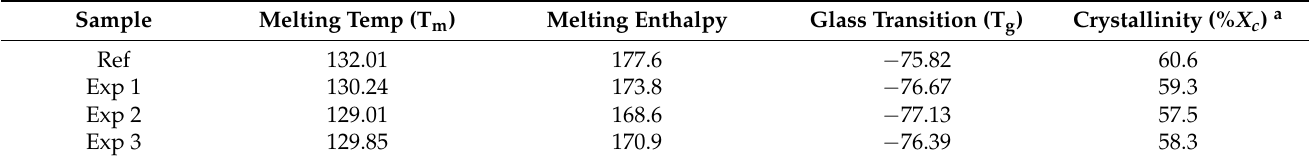
Table 5. Thermal properties for virgin and aged samples.